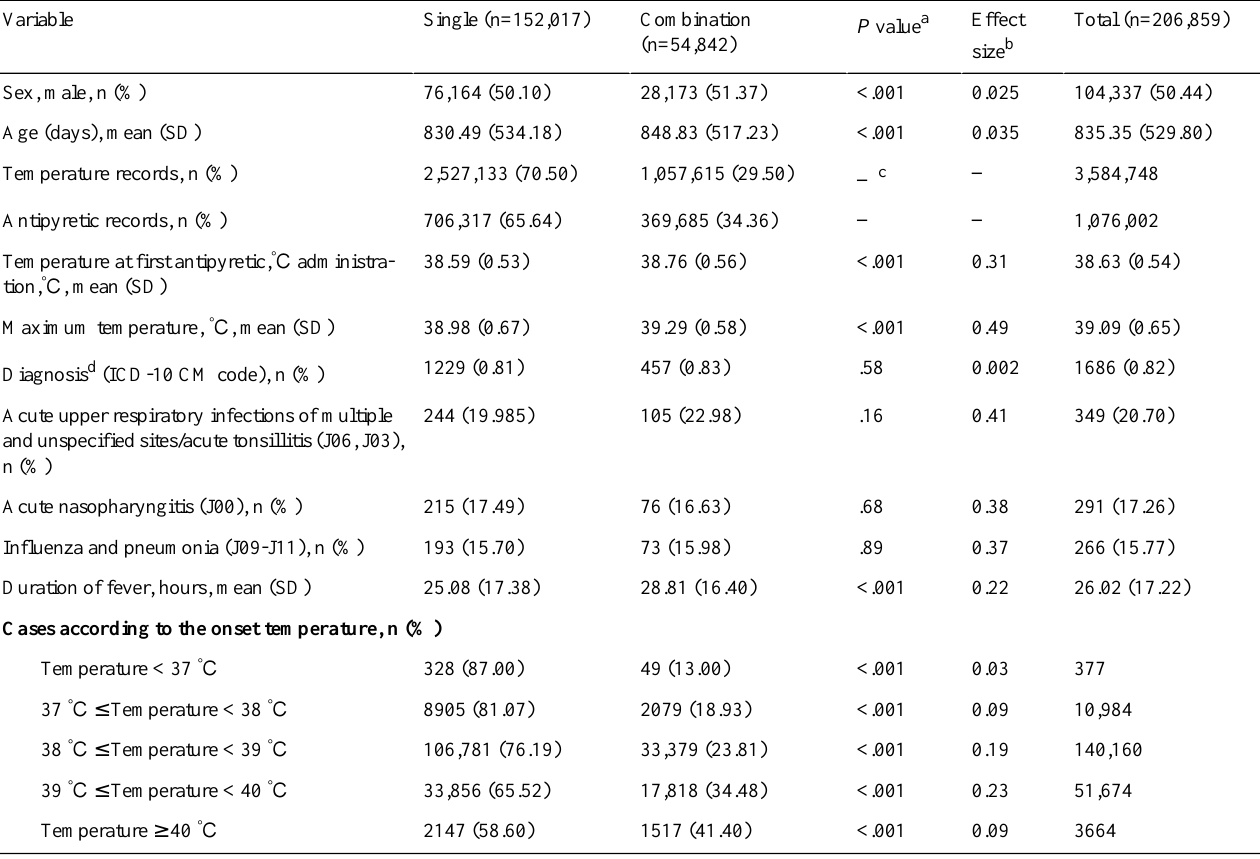
Table 1. Descriptive statistics and children’s temperature records according to antipyretic drug administration pattern (single or